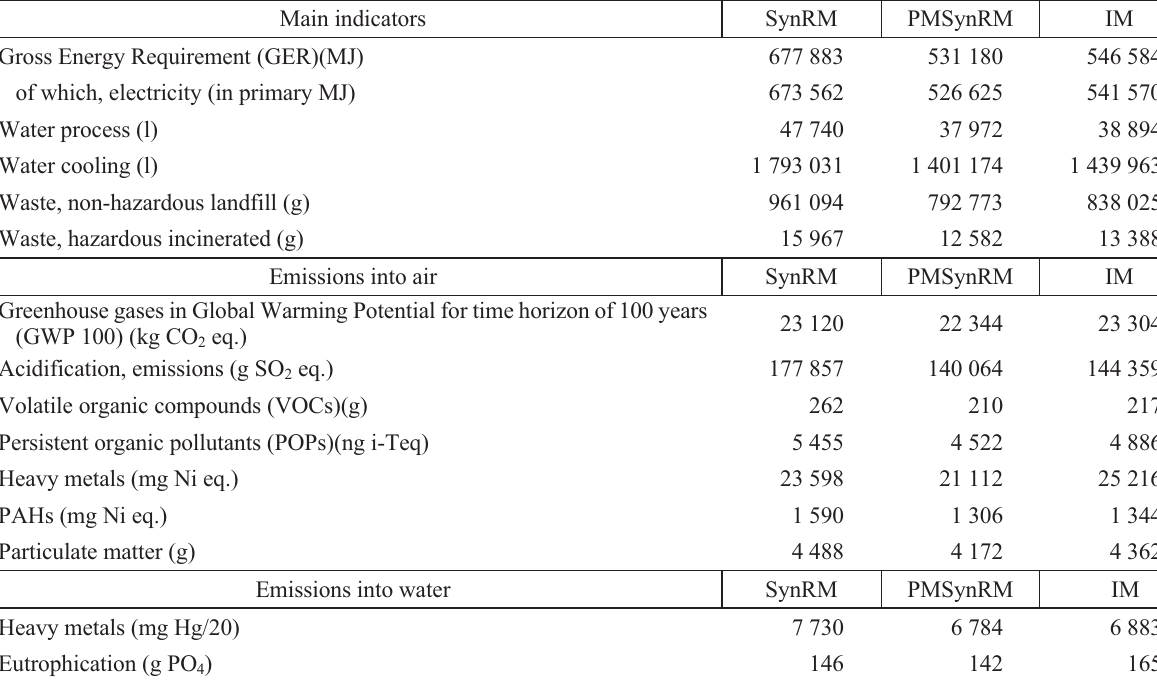
Table 4. Life cycle indicators of the environmental impact made by the